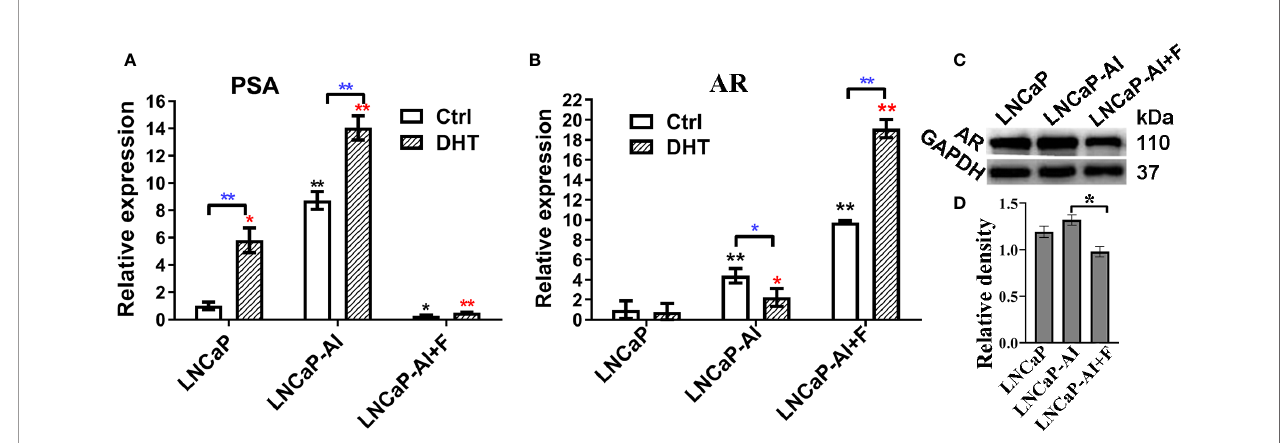
FIGURE 1 | Expression of AR and PSA in PCa cells. (A, B) Relative PSA and AR mRNA expression is shown in PCa cell lines tested by qRT-PCR. LNCaP cells were cultured for 3 days while LNCaP-AI cells cultured for 2 days in CS-FBS medium treated with ethanol or 10 nM DHT. The results are expressed as the mean ± S.D. of three biological replicates and normalized to GAPDH. *, P<0.05 or **P<0.01 vs LNCaP cells treated with alcohol or 10 nM DHT; one-way ANOVA followed by LSD multiple comparison test among three cell lines or T test for the same cell line treated with alcohol or 10 nM DHT. (C, D) AR protein expression in the three PCa cells. (C) Total AR expression in the three PCa cell lines is shown using WB. (D) The density of each AR band in three independent experiments of (C) was determined (*P < 0.05; one-way ANOVA followed by LSD multiple comparison test,